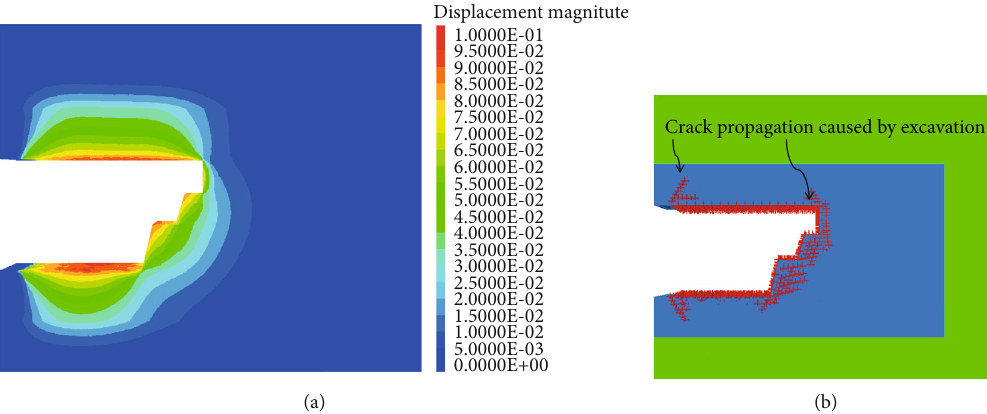
Figure 6: Tunnel displacement and crack propagation when safety thickness is 5m. (a) Displacement nephogram. (b) Fracture fi eld distribution.